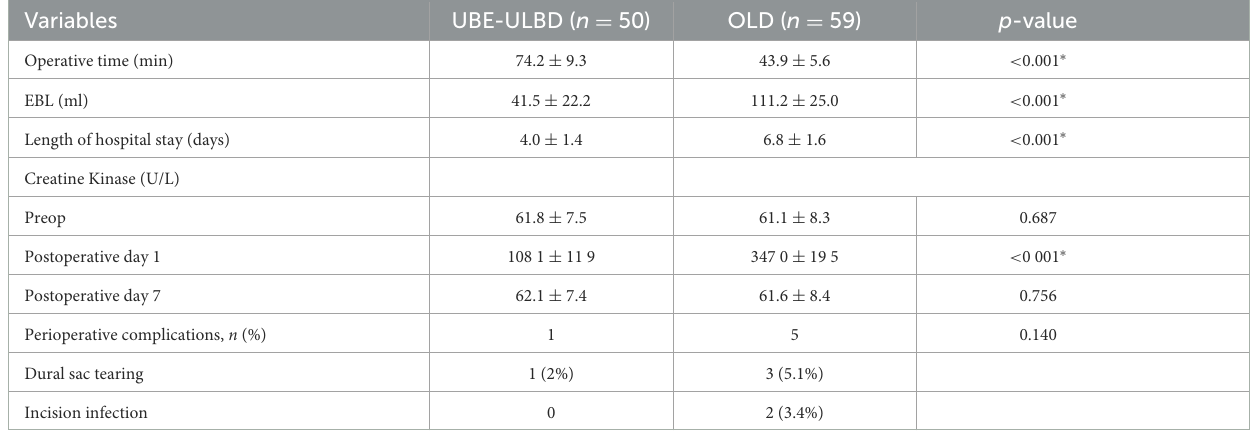
TABLE 2 Perioperative characteristics by type of procedure.